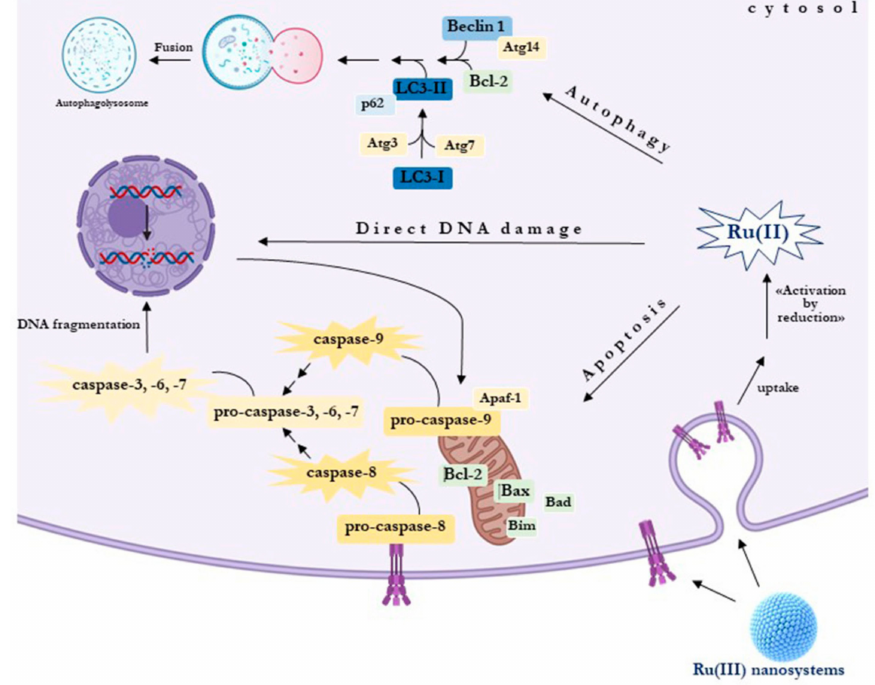
Figure 5. Molecular model proposed to describe the mechanism of action underlying the antiproliferative e ff ect in BBC of nucleolipid nanosystems delivering the Ru(III) complex AziRu. Following uptake and selective activation in situ, this model highlights the multitarget action of the drug on the activation of both apoptotic and autophagic cell death